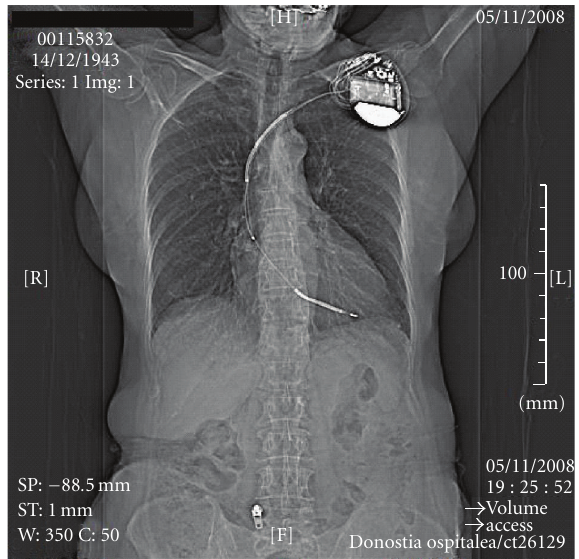
Figure 1: CT topogram. Initial topogram of the scan, showing the implanted device in the left pectoral zone and both electrodes. Arrows: date and time of scan.